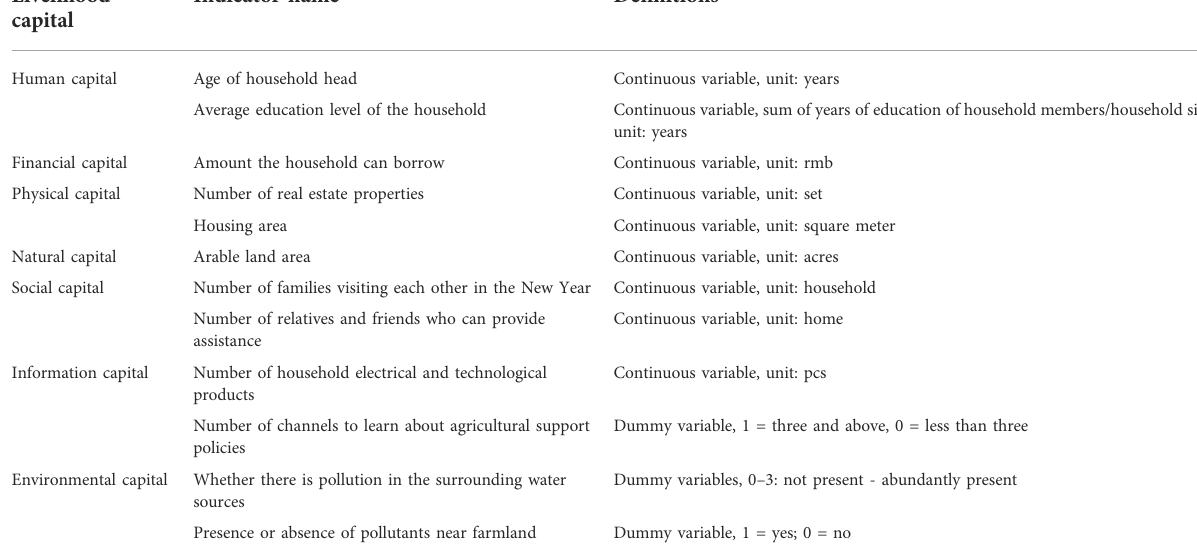
TABLE 2 Evaluation system for constructing indicators of sustainable livelihood capacity of farm